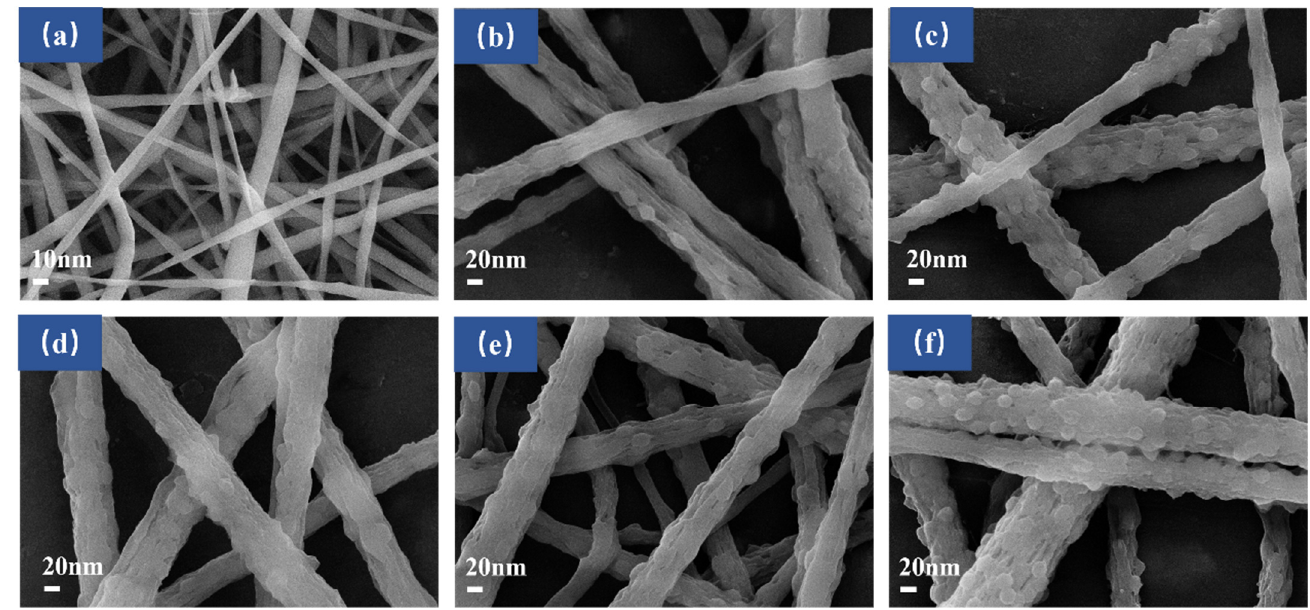
Figure 3. SEM of ( a ) PVDF (×10k), ( b ) PVDF–1GO (×20k), ( c ) PVDF@GO (×20k), ( d ) PVDF–2GO (×20k), ( e ) PVDF–1GO@GO (×20k), and ( f ) PVDF–2GO@GO (×20k) . ( × 20k), ( e ) PVDF–1GO@GO ( × 20k), and ( f ) PVDF–2GO@GO ( ×